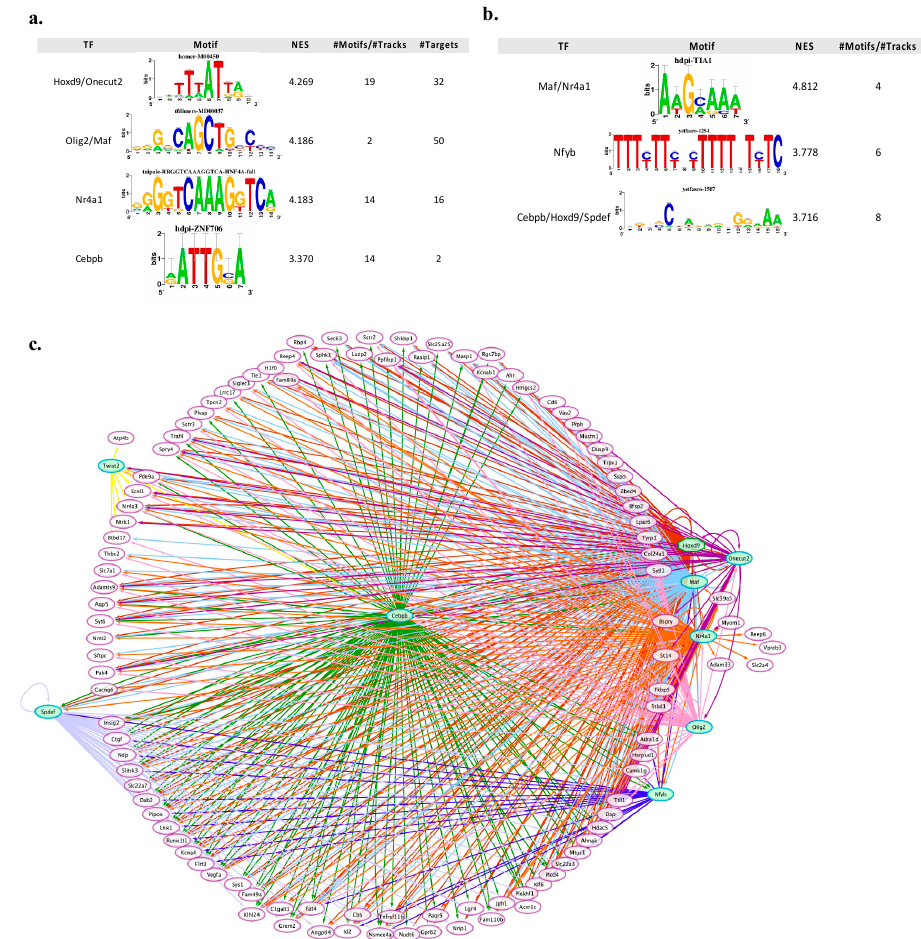
Figure 6. The upstream regulatory network is predicted to regulate the expression of the survival-related gene signatures in CGNs. ( a ) Result summary of the regulatory analysis with iRegulon on up-regulated core set genes. ( b ) Result summary of the regulatory analysis with iRegulon on downregulated core set genes. In particular, the top transcription binding motifs and their associated transcription factors (filtered for TF differentially expressed in our analysis) are shown. ( c ) The whole overview of the regulatory network of 9 key TFs together with their core set candidate targets. The network was visualized by Cytoscape . Targets are in white circle nodes with purple borders and TF in green hexagon nodes. Regulons for each TF are represented by different edge